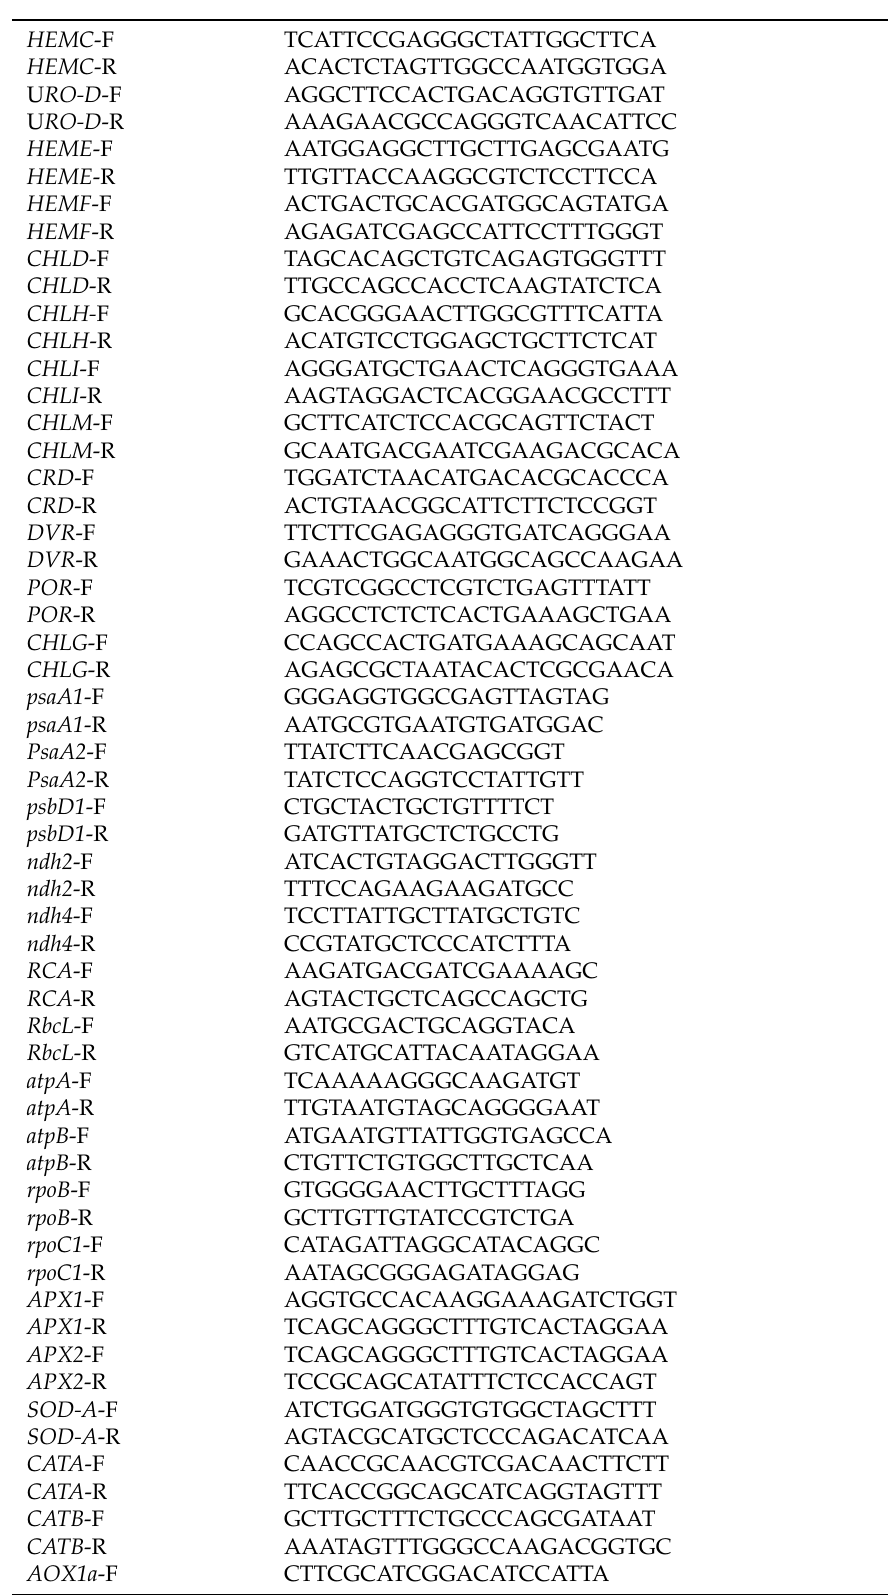
Table A4. Cont. HEMC -F HEMC